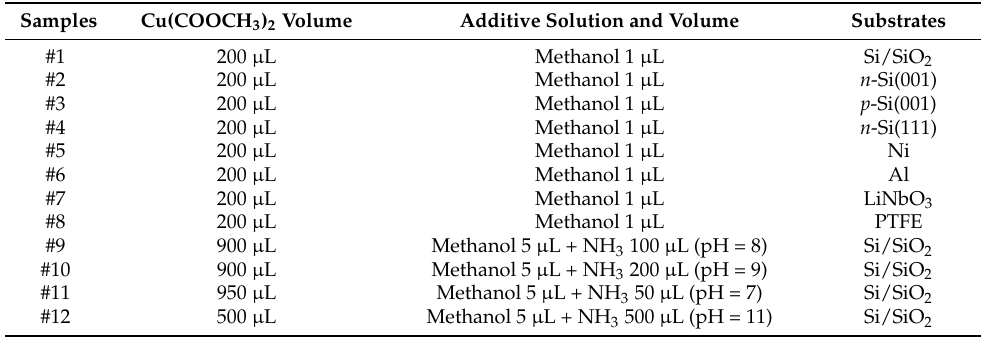
Table 1. List of nanoparticles synthesised by X-ray radiolysis.